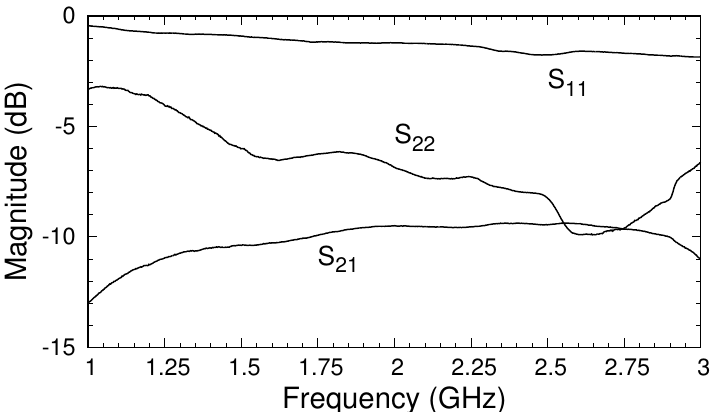
Figure 11. Magnitude of measured S-parameters after calibration for a sample of FGM-125.